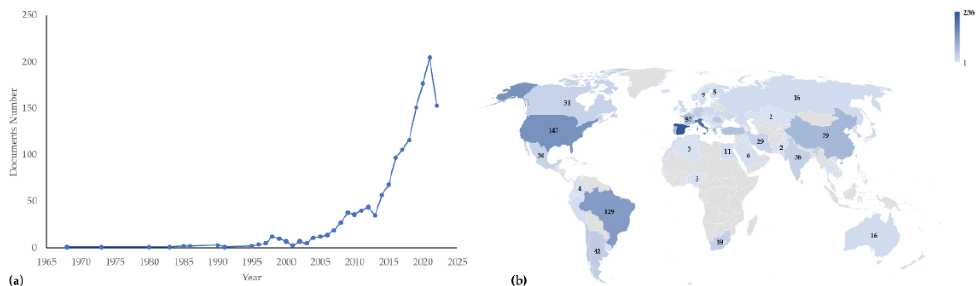
Figure 1. Number of documents with “grape pomace” in the title, abstract and keywords by year ( a ) and by country ( b ) according to Scopus on 19 September 2022 (Total number of documents = 1473).